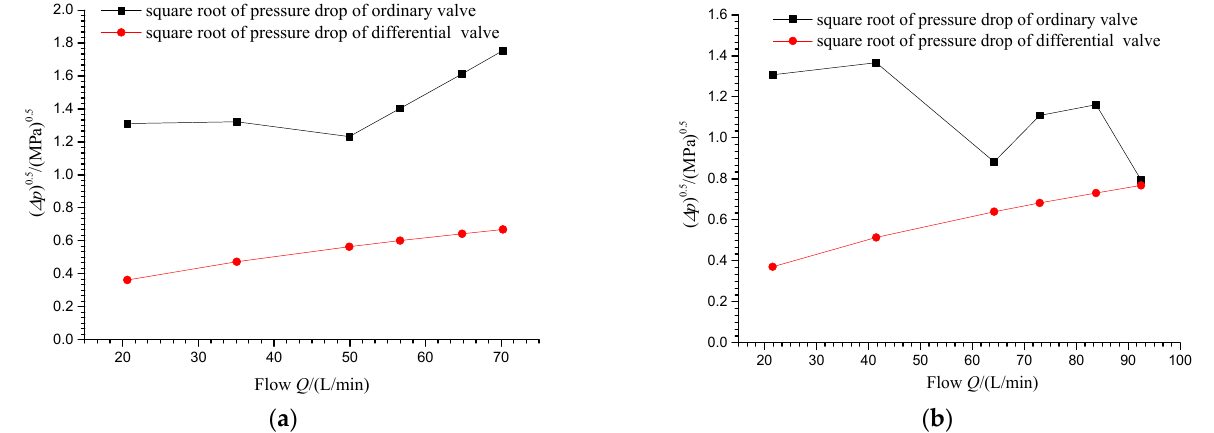
Figure 13. The relationship between flow and square root of pressure drop of ordinary valve and differential valve when hydraulic cylinder is operated; ( a ) Retracted; ( b ) Extended.